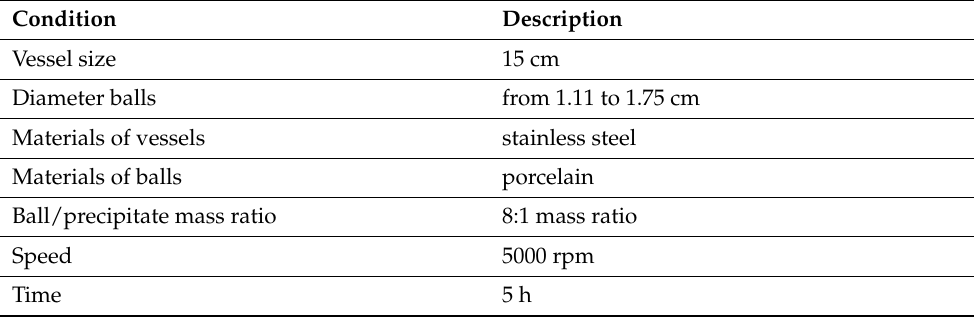
Table 1. The ball milling conditions for preparing